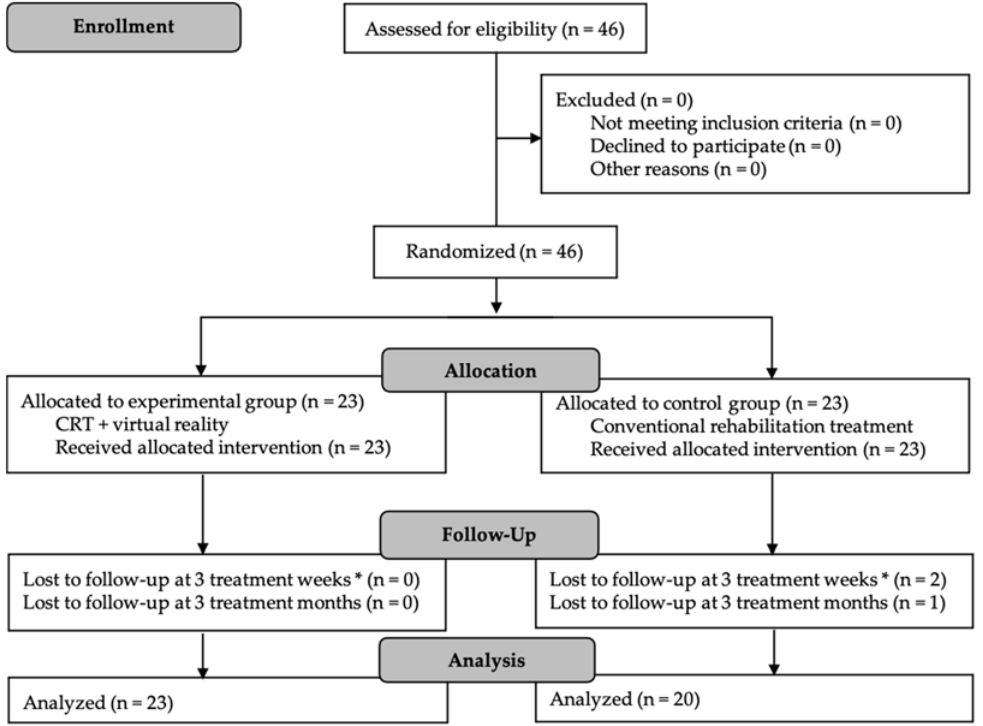
Figure 2. CONSORT flow diagram for participant recruitment, allocation, follow-up, and analysis. CRT: conventional rehabilitation treatment. * Post-intervention evaluation. Table 1. Characteristics of the participants of both groups ( n = 43).